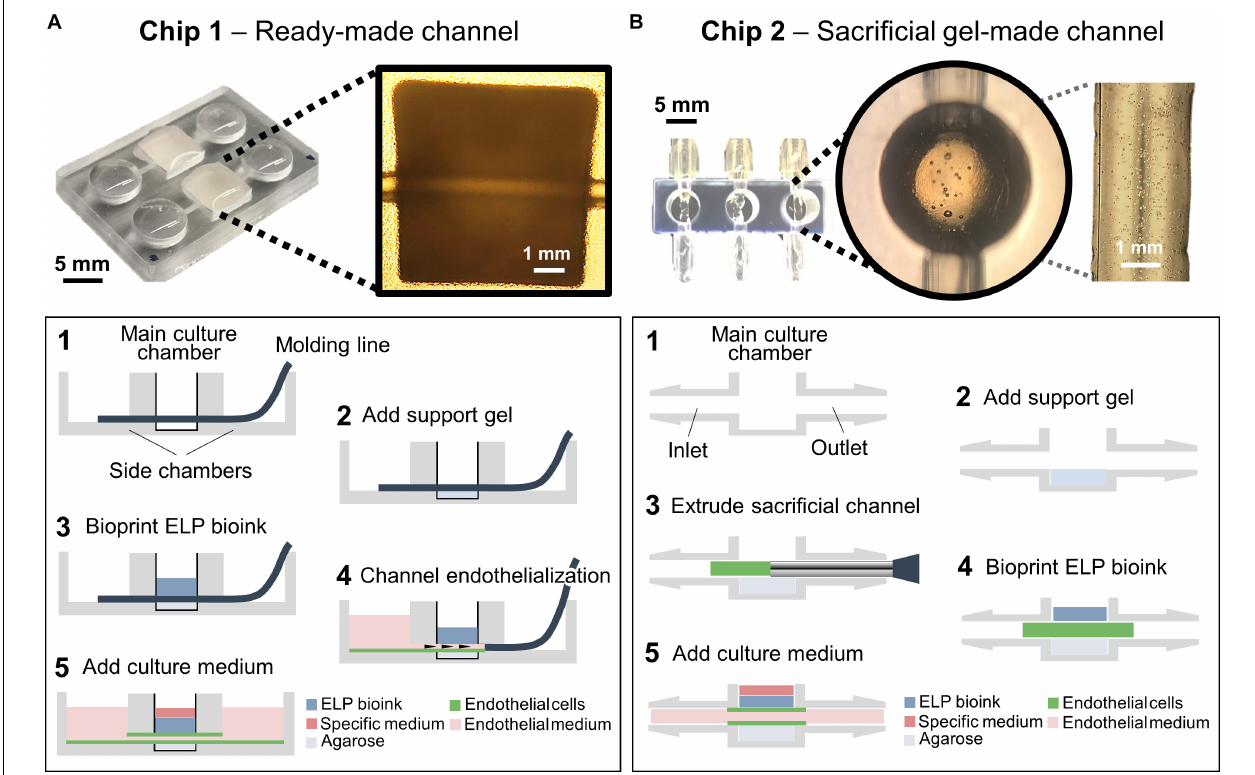
FIGURE 2 | Chip designs used for the biofabrication of printed tissue frameworks with on-chip vascular-like channels. Chips designs with (A) ready-made channels, and (B) sacrificial gel-made channels were evaluated. Sequence of events (1–5) indicates the necessary working steps to fabricate both types of tissue models. Sacrificial gel-made channels can be used to incorporate endothelial cells that will form monolayers on the channel surface after removing the sacrificial gel. The inset photograph in (A) shows the channel formation at step 5. The inset photograph in (B) shows the presence of endothelial cells inside the sacrificial gel at step